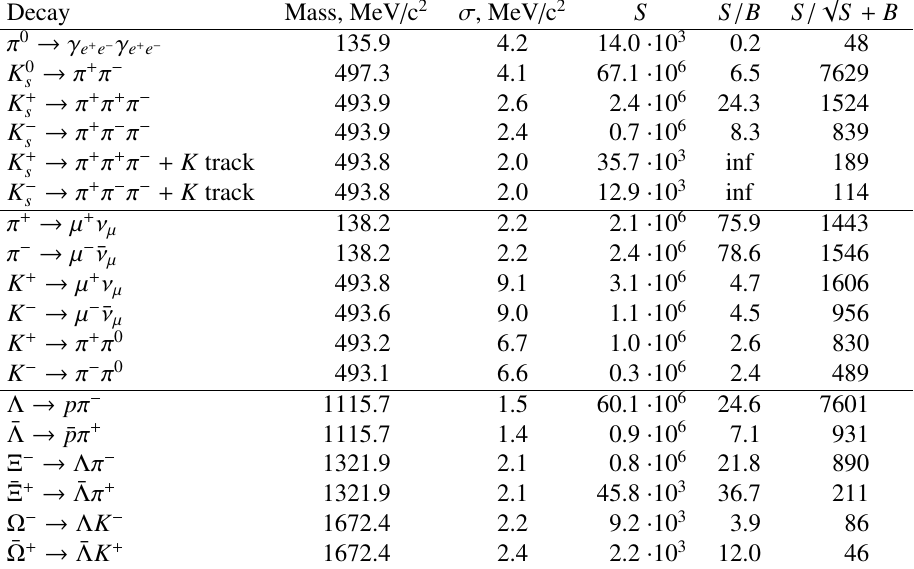
Table 1. Results of the search for mesons and hyperons in the STAR HLT express data stream.